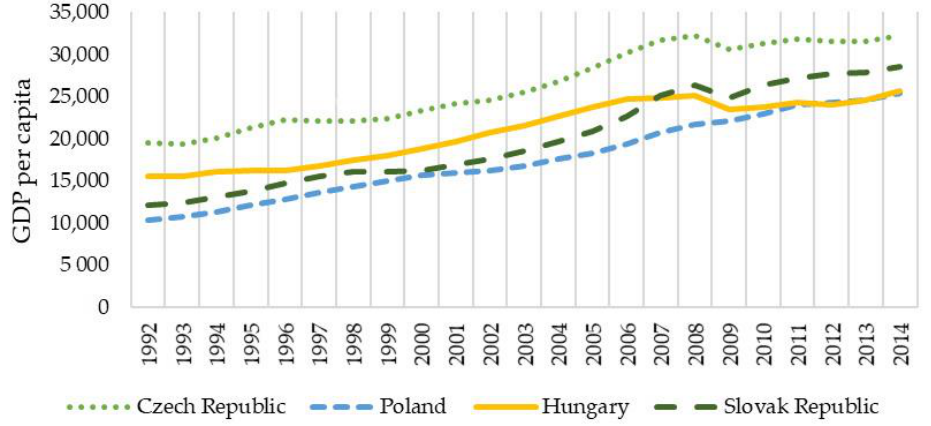
Figure 4. A plot of GDP per capita for V4 countries in 1992–2015. Data on the correlation between the studied variables are presented in Table 2 and visualized in Figure 5. The results show that there is a relationship between the studied variables. For the CO 2 variable and GDP per capita data, the correlation coefficient took negative values. Additionally, a negative correlation occurred in the case of energy con- sumption and GDP per capita in Slovakia, which was the only such observation in the analyzed group of countries. There was also a positive correlation between the level of energy consumption and CO 2 emissions; in the Czech Republic, the index had the lowest value (0.265), while the highest value was the index for Poland (0.655) and Slovakia (0.759). Table 2. The matrix of correlation coefficients for the analyzed variables.